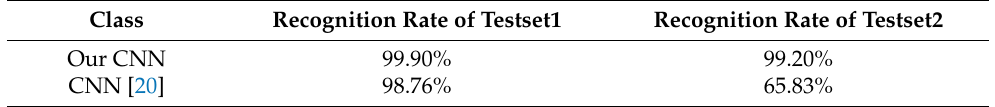
Table 3. Comparation of neural